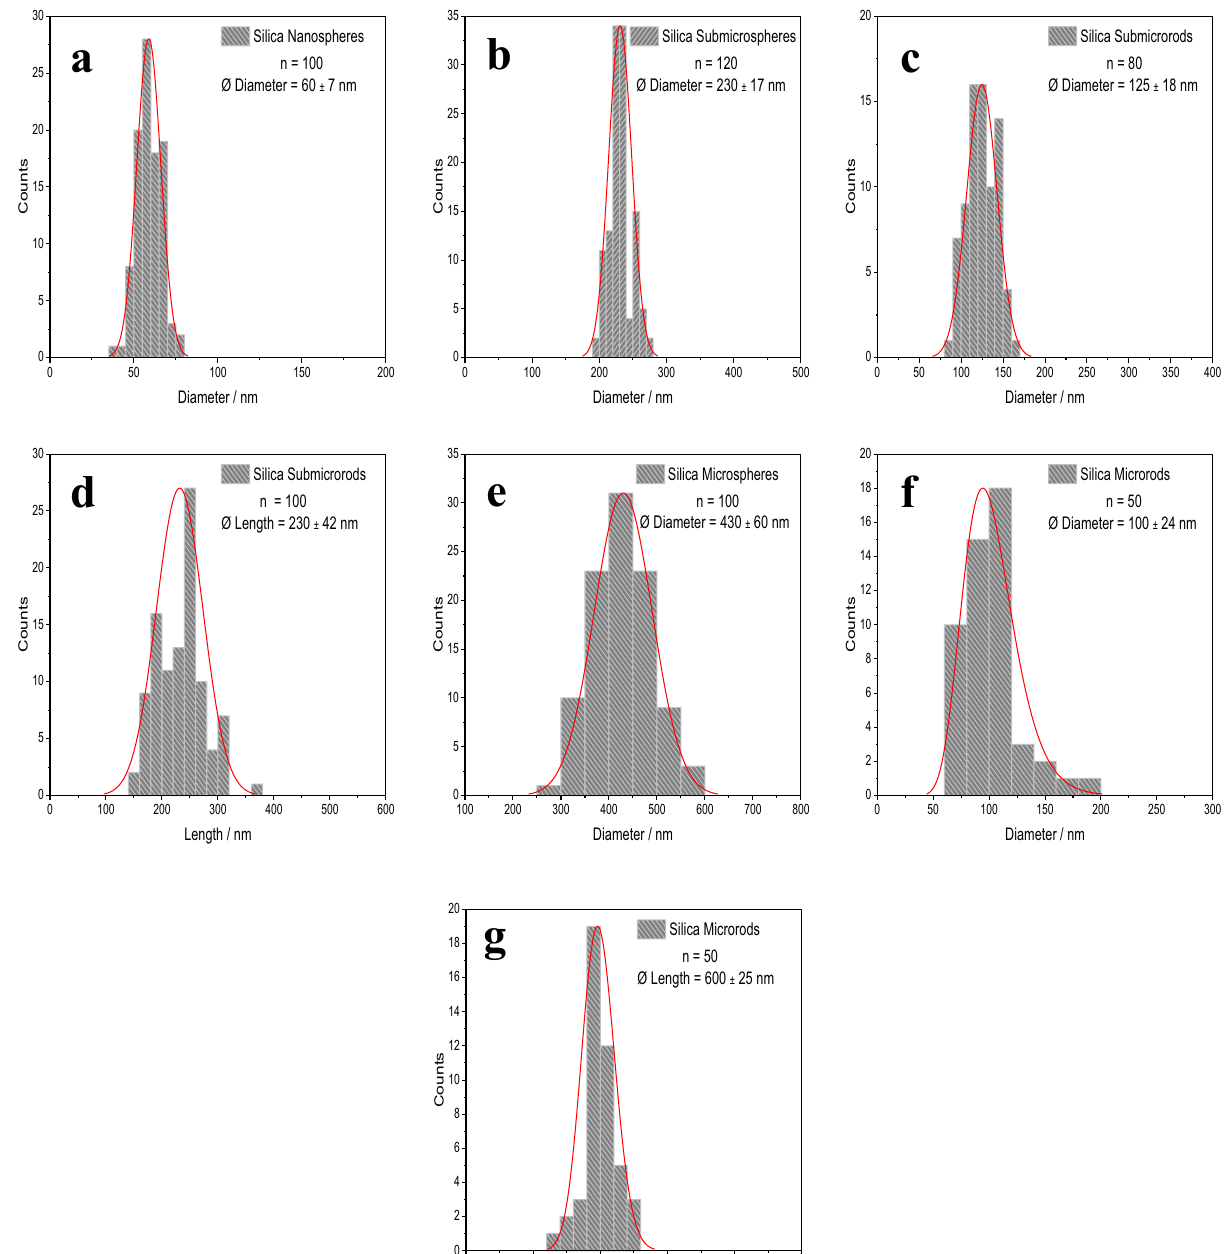
Figure 2. Particle size distribution (LogNormal) by SEM analysis for all unfunctionalized silica particles: Diameter of nanospheres ( a ), diameter of submicrospheres ( b ), diameter of submicrorods ( c ), length of submicrorods ( d ), diameter of microspheres ( e ), diameter of microrods ( f ), length of microrods ( g